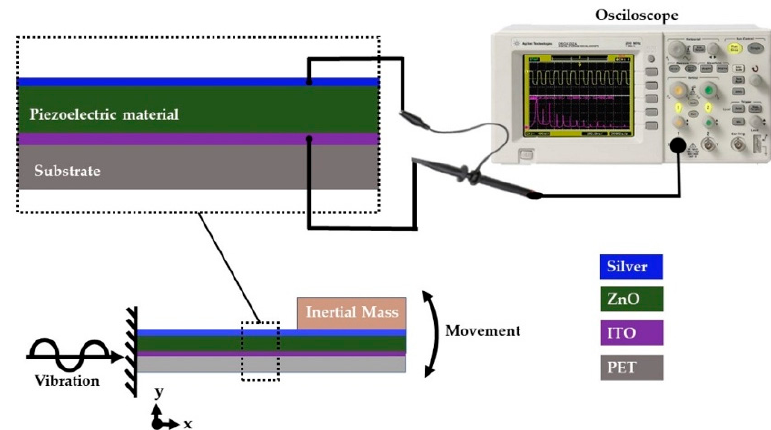
Figure 6. Schematic view of the open voltage (Voc) characterization system of the flexible pVEH microdevice.